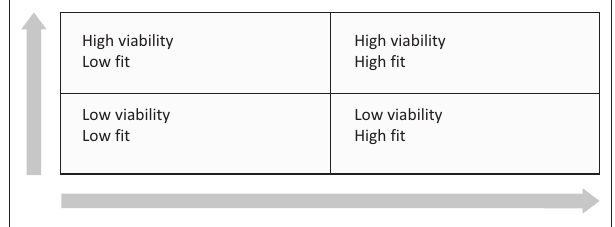
FIGURE 1: Fit and viability